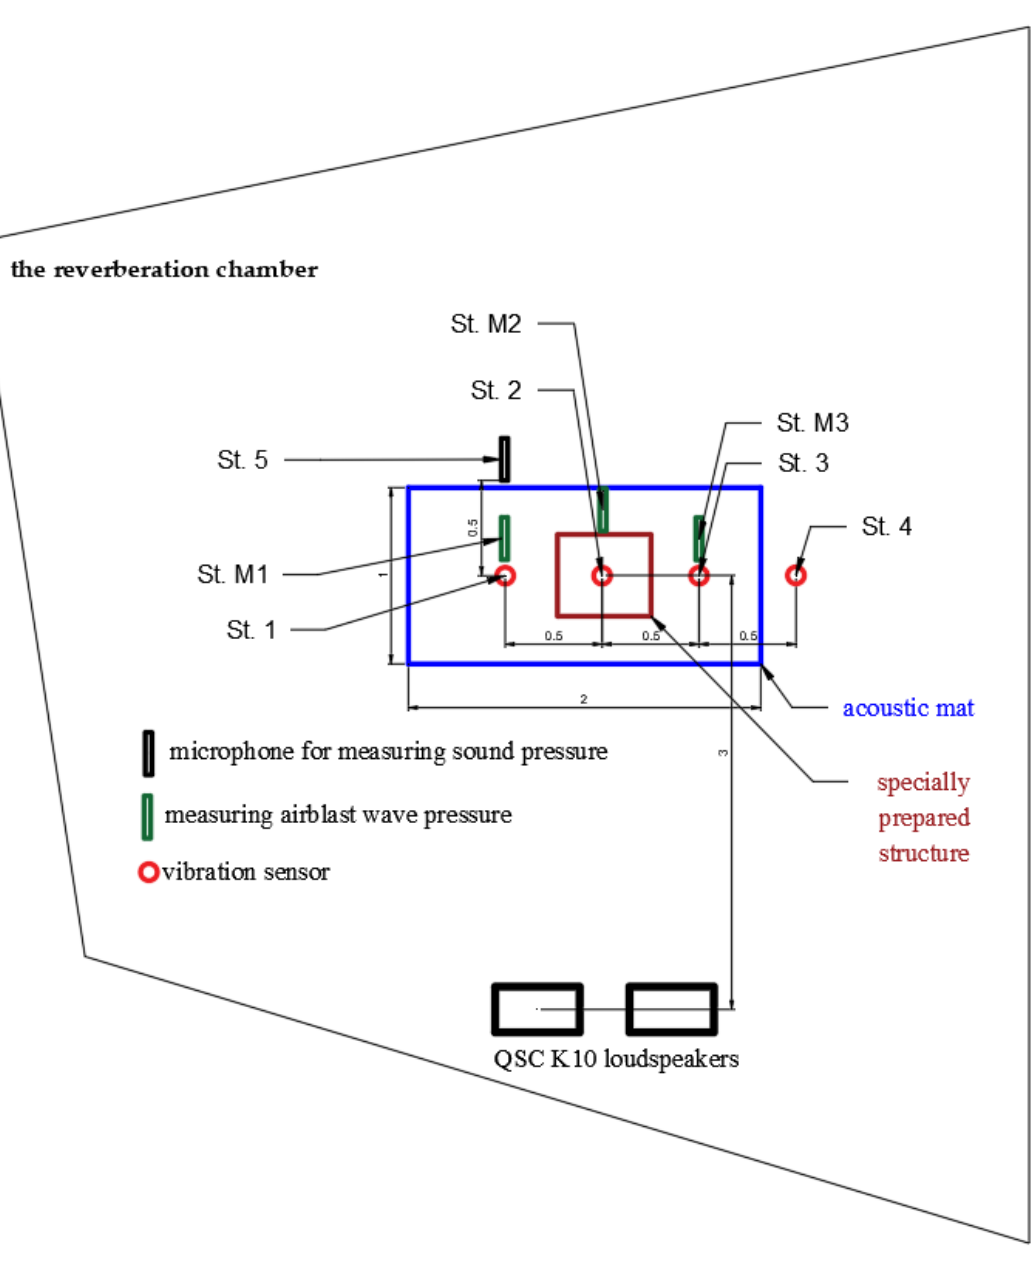
Figure 2. Distribution of sensors in the reverberation chamber.